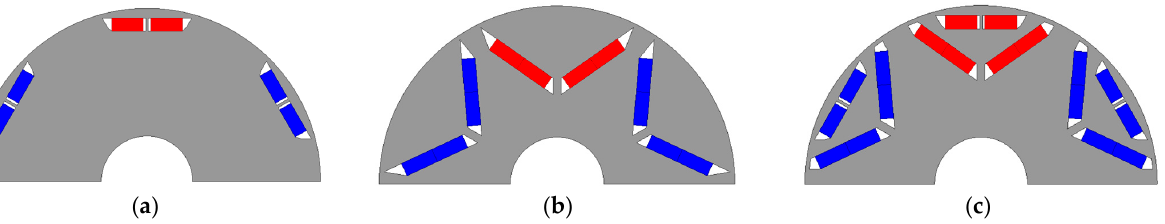
Figure 5. IPMSM Rotor Structures: ( a ) Bar Shape. ( b ) V Shape. ( c ) ∇ Shape.